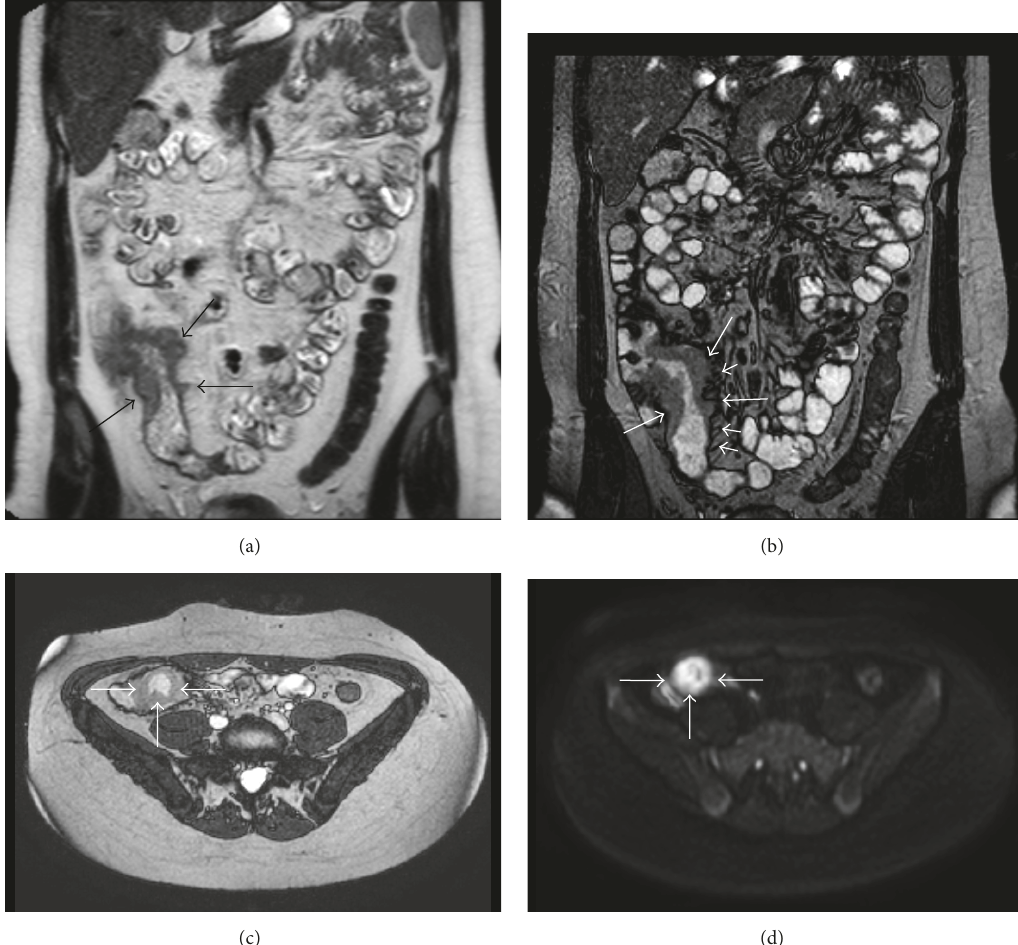
Figure 1: Diffuse bowel wall thickening with polypoid appearance (long arrows) and ectatic vasa recta (short arrows) are well demonstrable on coronal HASTE (a) and True-FISP (b) MR images as well as on axial True-FISP MR image (c). Axial diffusion-weighted MR image, performed at 𝑏 -value of 800 s/mm 2 , shows restricted diffusion of water within the affected bowel wall